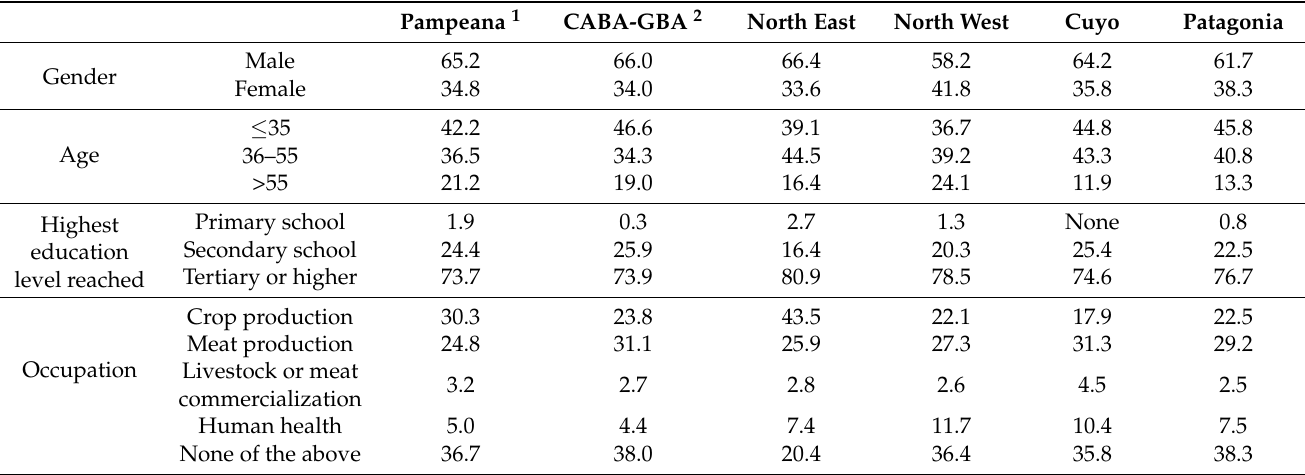
Table 1. Socio-demographic characteristics of the respondents. Data are percentages of valid answers, shown for each of the administrative regions of Argentina.